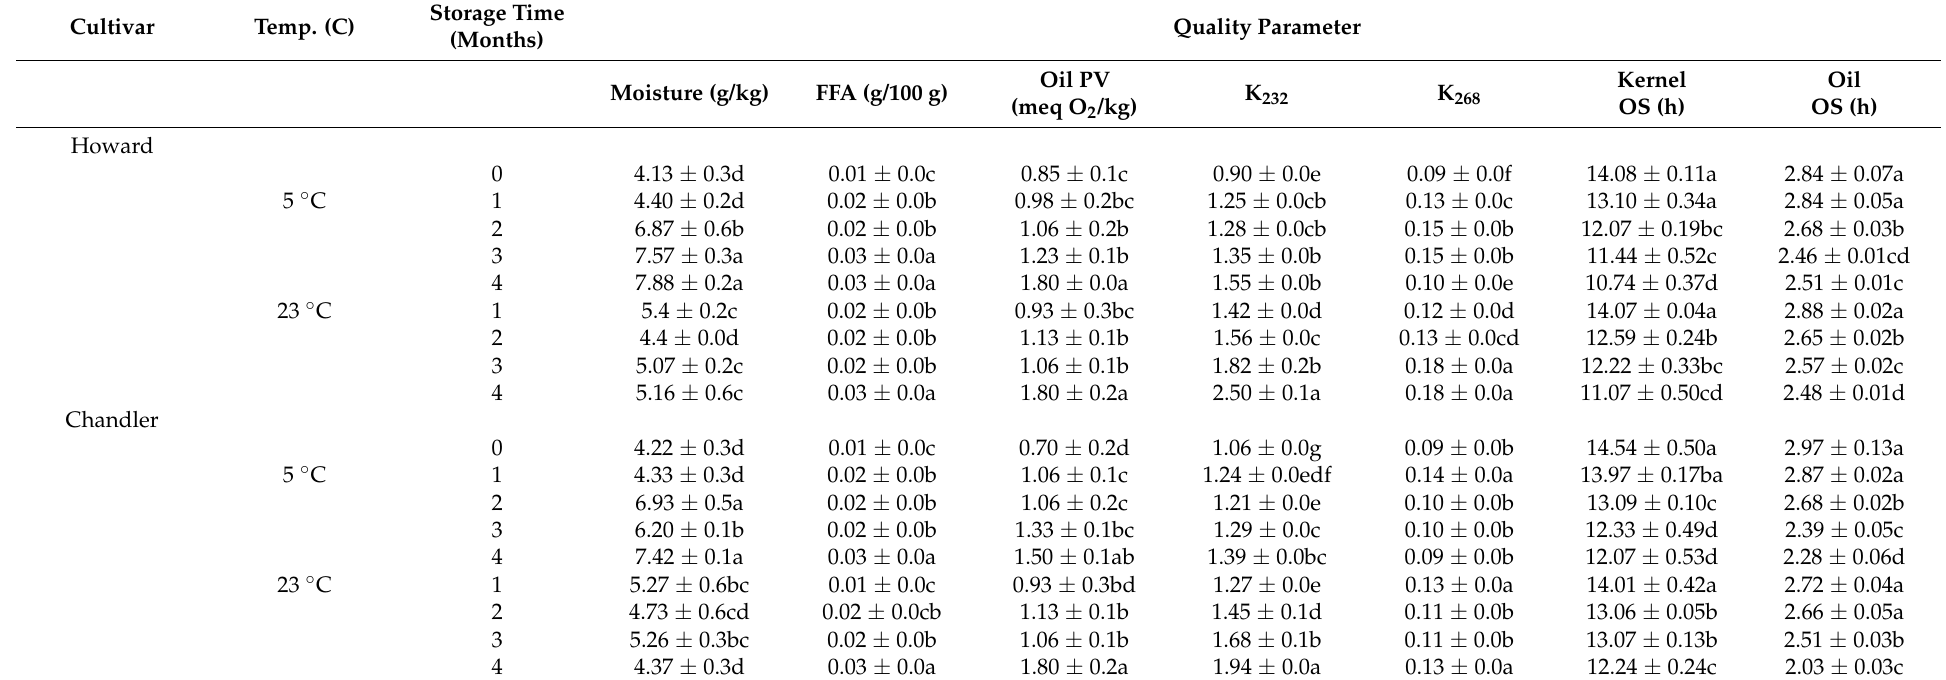
Table 1. Changes in quality parameters during